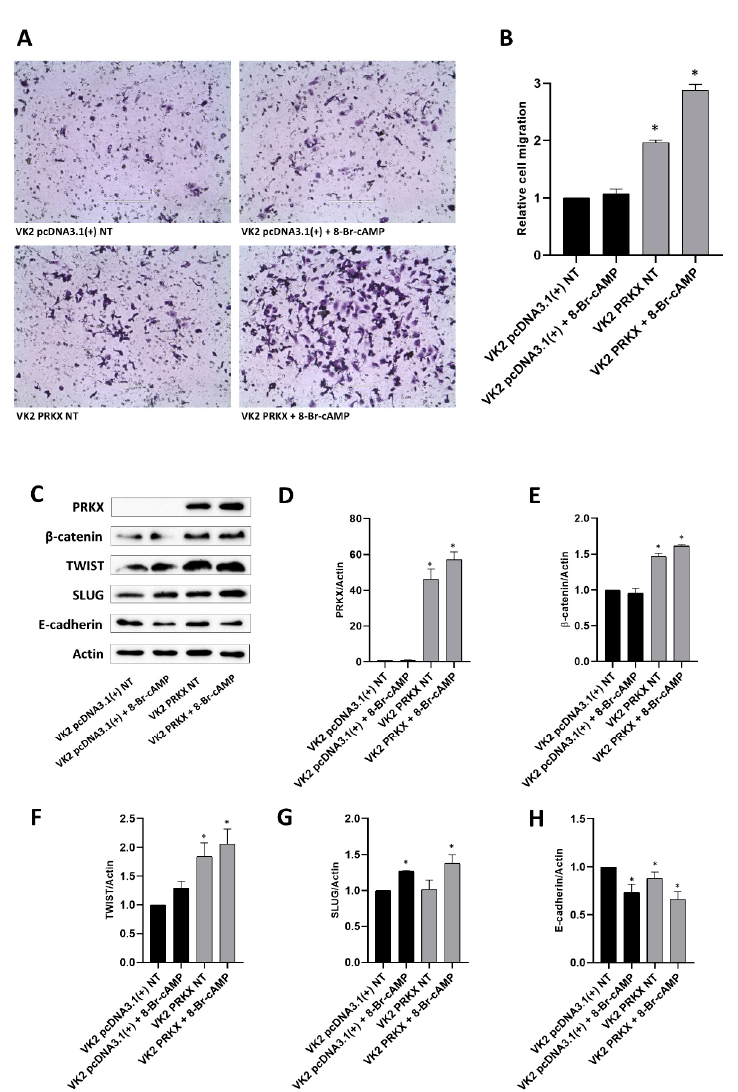
Figure 5. PRKX overexpression promotes the migration and EMT of human vaginal keratinocytes. ( A ) Representative pictures of crystal violet-stained VK2 E6/E7 migrated through 8 µm porous membranes, transfected with pcDNA3.1(+) or pcDNA3.1(+)-PRKX in the presence or absence of 8-Br-cAMP (10× magnification). ( B ) Relative fold increase in cell migration resulted from ImageJ total cell count. (mean ± SD; n = 2; * p < 0.05; Student’s t -test). ( C ) Representative Western blot for PRKX, β -catenin, TWIST, SLUG and E-cadherin in VK2 E6/E7 transfected with pcDNA3.1(+)-PRKX or pcDNA3.1(+) as control in presence or absence of 8-Br-cAMP ( β -Actin was used as loading control). ( D – H ) Densitometric analysis (mean ± SD; n = 2; * p < 0.05; Student’s t -test). The original Western blot images can be found in Figure S1.